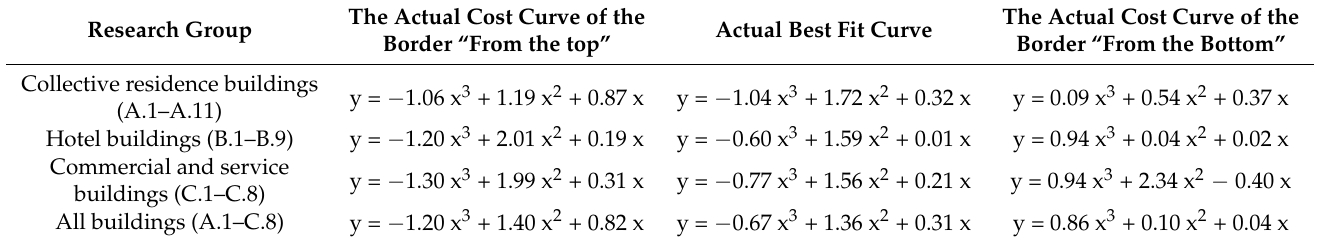
Table 5. Cost curve